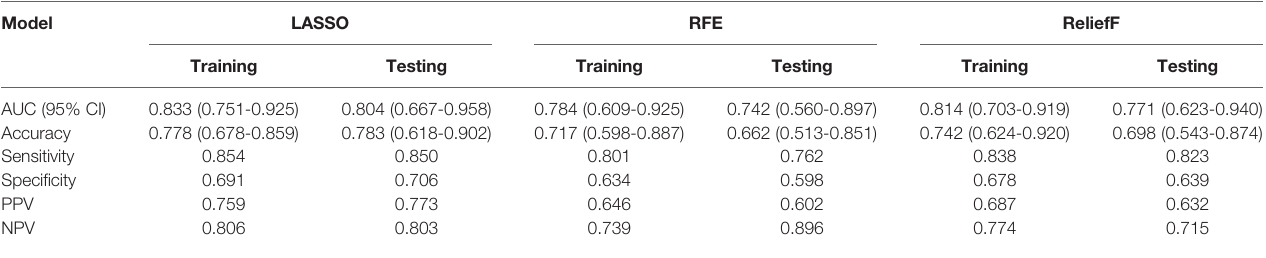
TABLE 3 | Predictive performance of three feature selection